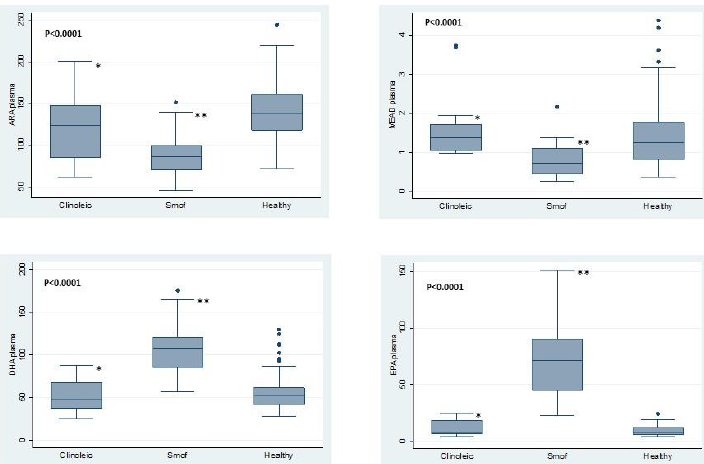
Figure 1. Plasma PUFAs in patients on SMOF or Clinoleic and healthy children: Mead acid (MA); arachidonic acid (ARA); eicosapentaenoic acid (EPA); docosahexaenoic acid (DHA). · p -value for the di ff erences between 3 data series are reported in each panel. Under each panel are reported statistically significant di ff erences between 2 groups: SMOF vs. Clinoleic; SMOF vs. healthy children. Di ff erences between 2 groups: ** p < 0.01 SMOF vs. Healthy; * p < 0.01 SMOF vs. Clinoleic.